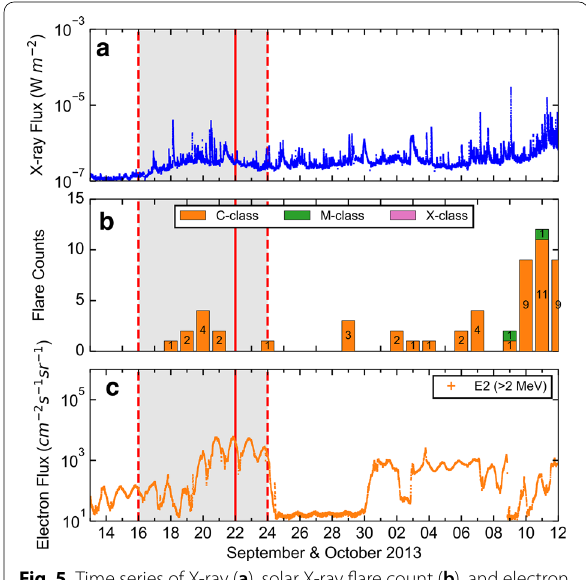
Fig. 5 Time series of X-ray ( a ), solar X-ray flare count ( b ), and electron flux ( c ) during the period from 13 September to 11 October 2013, which were measured by the GOES 15 geostationary satellite. Solar X-ray flux (https ://satda t.ngdc.noaa.gov/sem/goes/data/ avg/2013/09/goes1 5/netcd f/) was measured at the wavelength of 0.1–0.8 nm. Solar X-ray flare counts (https ://hespe ria.gsfc.nasa.gov/ goes/goes_event _listi ngs/) are classified into 3 categories (C, M, and X classes of these flares). Electron flux (https ://satda t.ngdc.noaa. gov/sem/goes/data/avg/2013/09/goes1 5/netcd f/) was measured at electron channels of E2 (> 2 meV). The life cycle of the Usagi was from 16 to 24 September 2013, as represented by the gray background area between two vertical red dashed lines. The vertical red solid line denotes the TC’s landfall near Hong Kong on 22 September